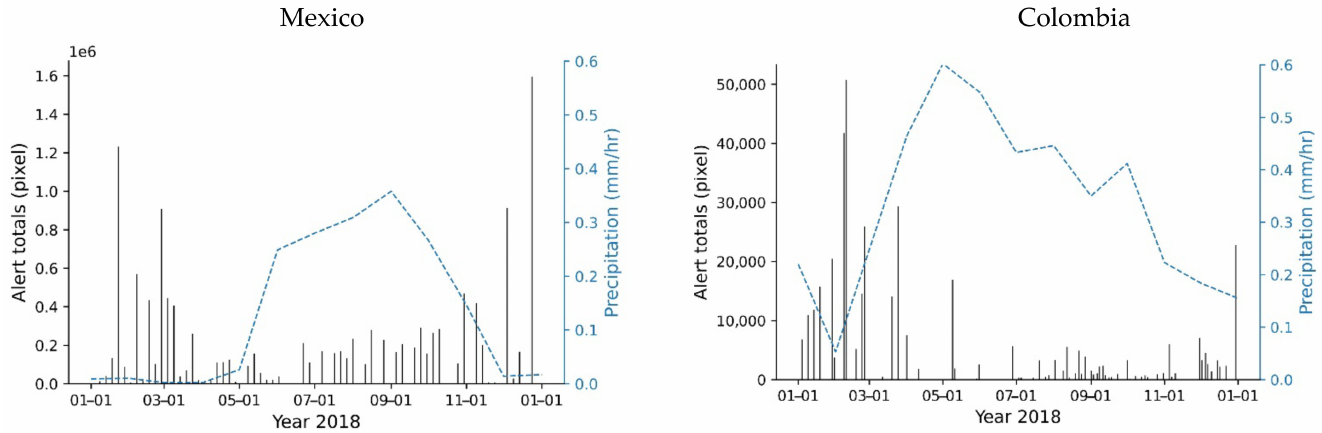
Figure 3. The temporal variation in the deforestation alerts for 2018 using Sentinel-2 images in the window areas for Manantl á n, Mexico, and Cartagena del Chair á ,